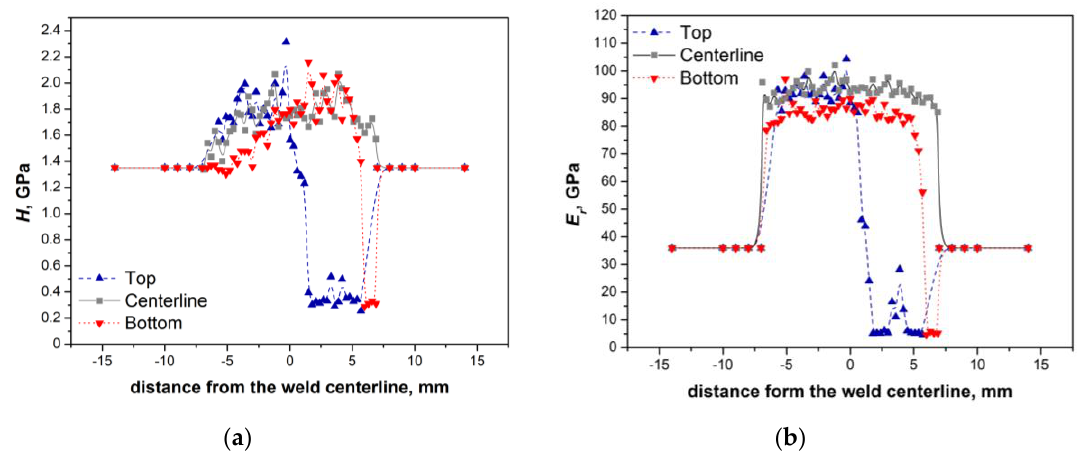
Figure 9. ( a ) Nanoindentation hardness and ( b ) nanoindentation Young’s modulus along different profiles of the cross-section of conventional FSW joints (Surface 1: 10 μm from the top surface of joint; centreline: at a middle height of thickness sample; Surface 2: at 10 μm from the bottom surface of joint).